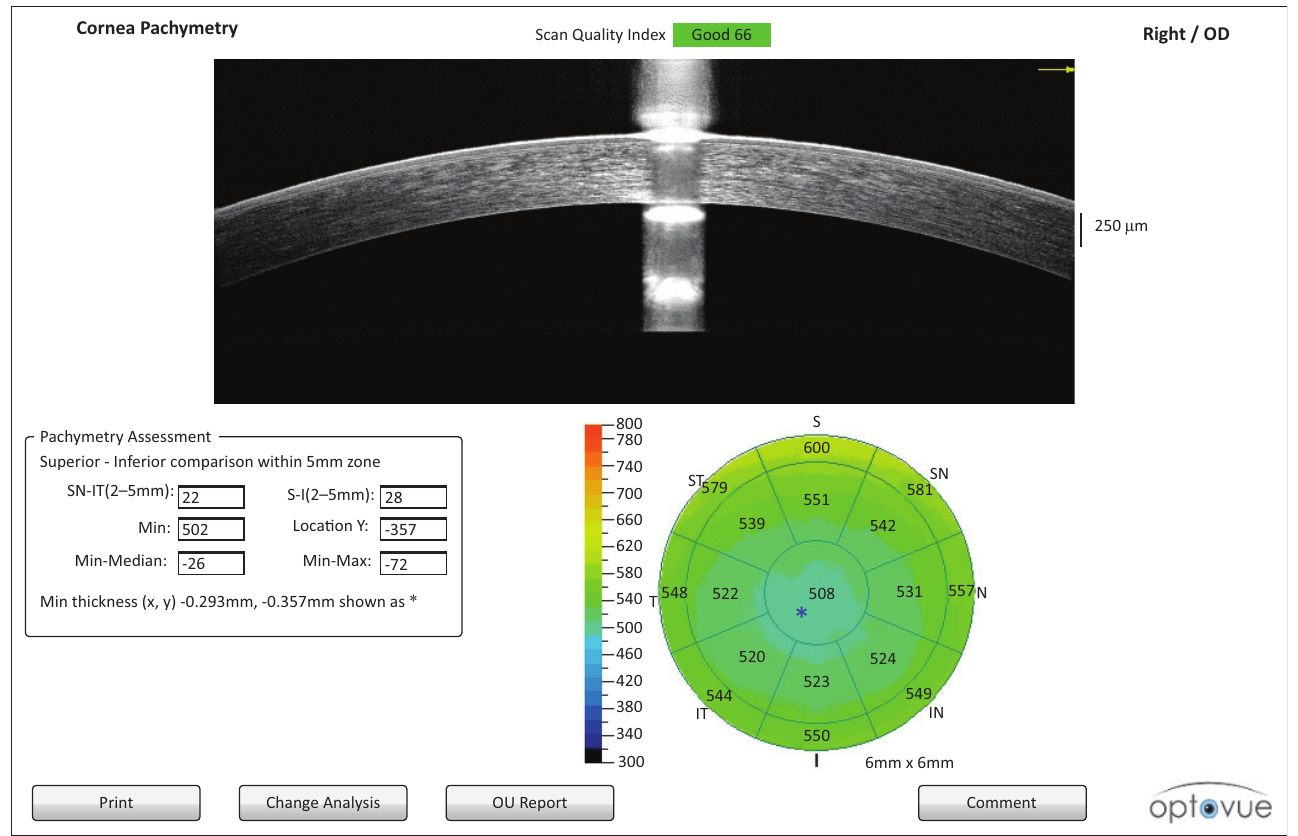
FIGURE 1: Corneal pachymetry map showing the mean corneal thickness in the centre and each zone in the paracentral and peripheral